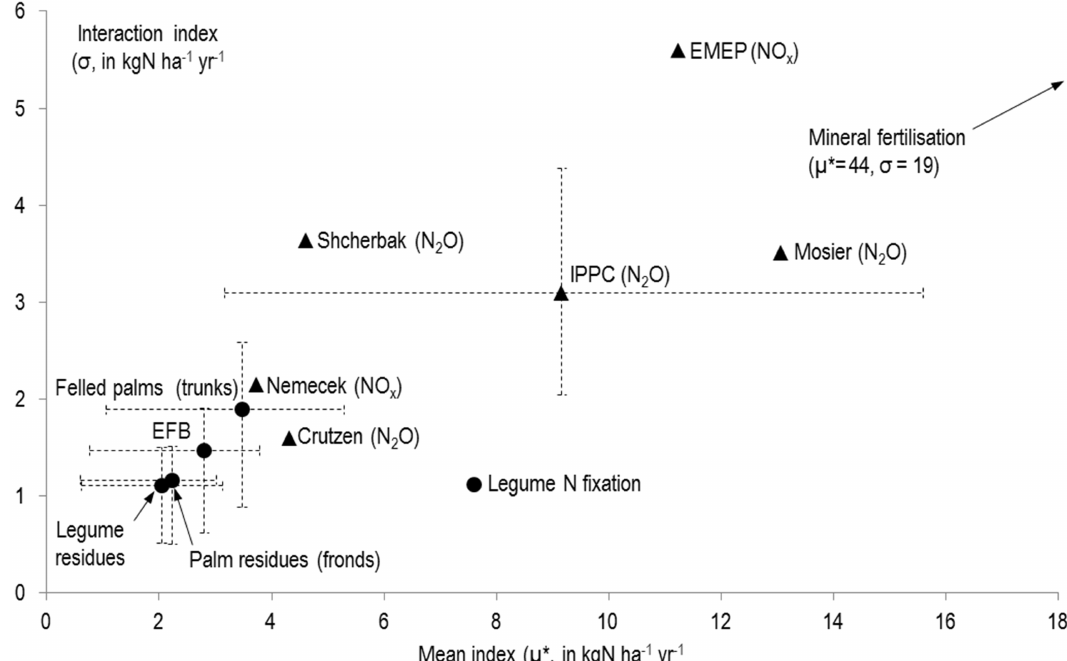
Figure 11. Morris’s sensitivity indices for sub-models calculating N 2 O, NO x , and N 2 emissions. Mineral fertiliser application had the highest indices (out of this graph). For other input variables, emission factors (triangles) had higher Morris indices than N inputs (circles). Sub-models tested: Mosier, IPCC-2006, Crutzen, Meier-2014, EMEP-2013, Nemecek-2012. Indices lower than 2kg Nha − 1 yr − 1 are not represented. EFB: empty fruit bunches, i.e. organic